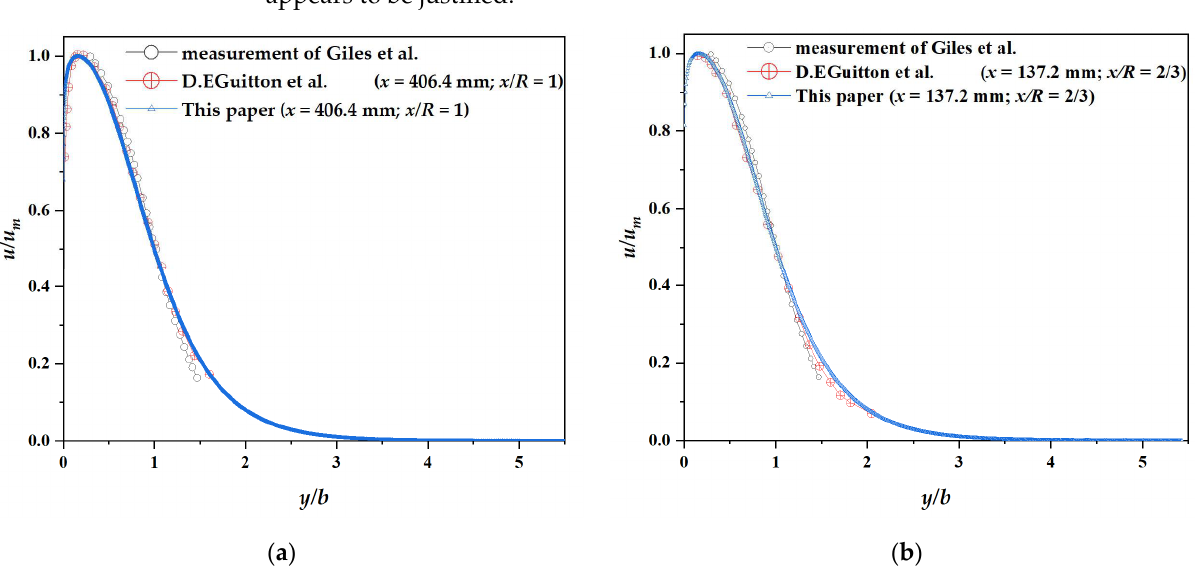
Figure 4. Jet growth with downstream distance. 3.3. Parameters Affect the Jet Flow and Lift Index on Logarithmic Spirals An analysis was performed to predict the effects of the three key parameters, i.e., jet exit velocity u i , non-dimensional jet downstream distance x / h , and the non-dimensional slot height h / R 0 , on the mean flow and lift capability in the wall jets of logarithmic spirals with x / R = 1 and x / R = 2/3. The H is 40 mm. 3.3.1. Jet Exit Velocity u i Figure 5 shows velocity distributions of wall flow on logarithmic spiral with different u i at x = 86 mm and h = 2 mm, where x is the distance from virtual origin of spiral. The